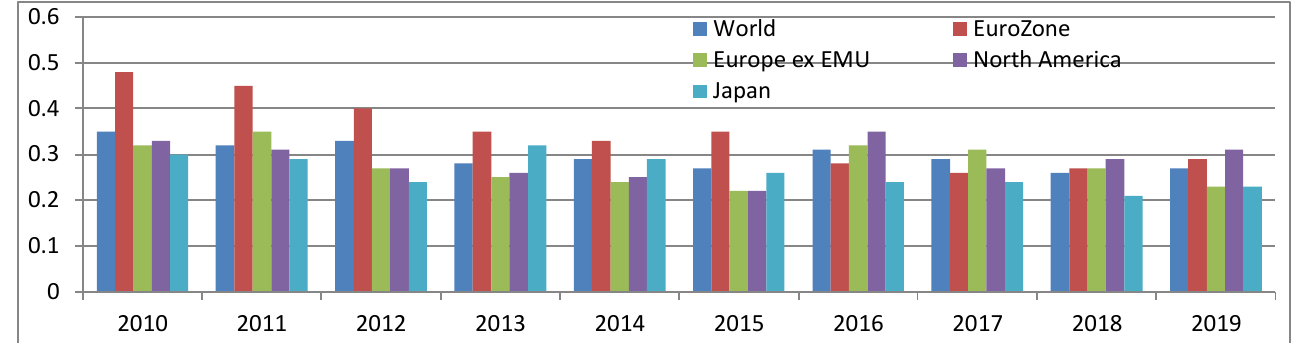
Figure 1: Region-wise dynamics of the average relative concerning carbon risk